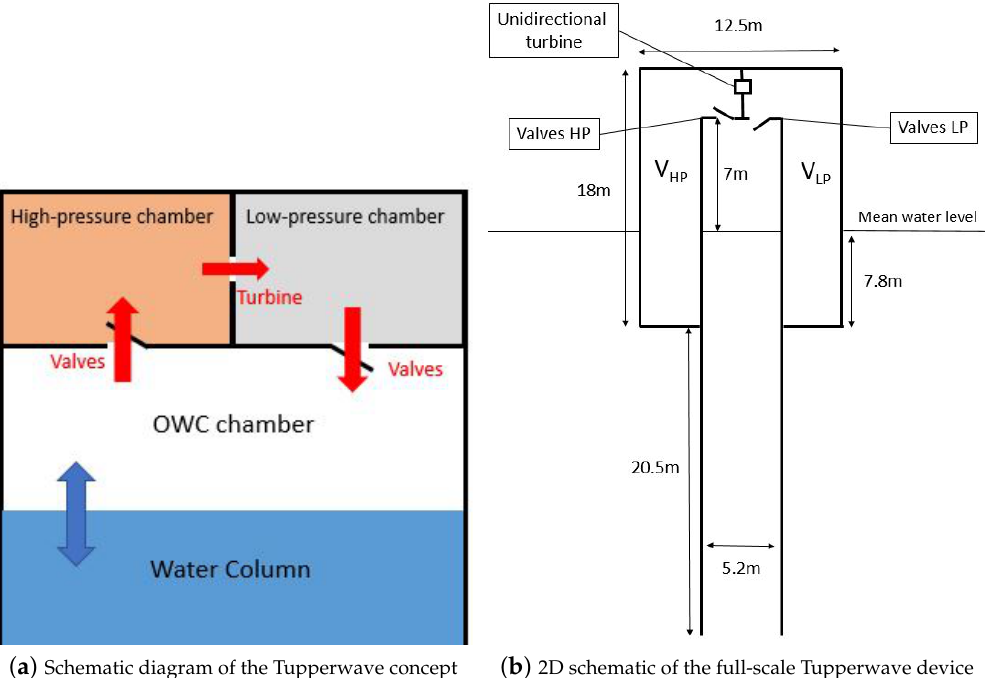
Figure 1. Tupperwave concept and application to a spar buoy.